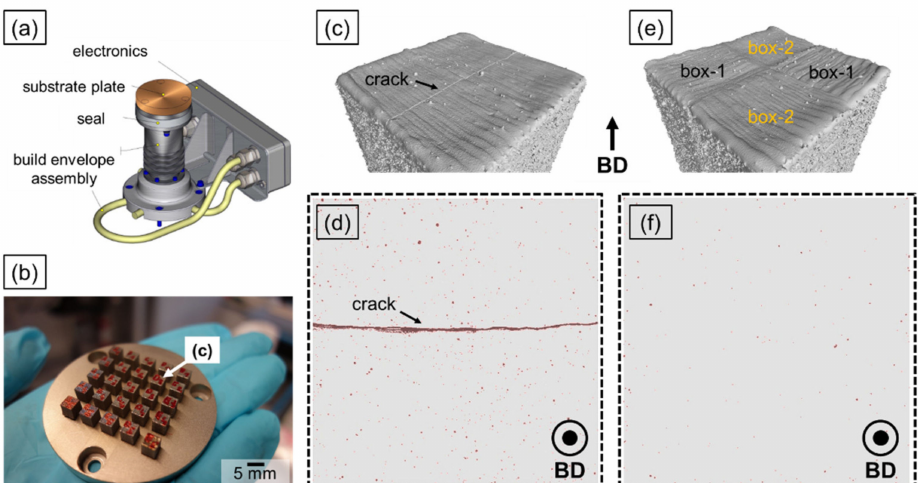
Figure 1. Overview of the machine setup used and selected Fe-Mn-Al-Ni samples fabricated at Leibniz IFW Dresden. An in-house developed build envelope (substrate plate diameter of 67 mm) was used for processing at a fixed temperature of 500 ◦ C ( a ). Process parameter optimization for Fe-Mn-Al-Ni ( b ) considering varying laser power (right to left: 125–225 W) and scanning speed (top to bottom: 610–890 mm/s). Reconstructed CT-images ( c – f ) revealing that crack free samples (5 mm × 5 mm × 7 mm) can be manufactured using the optimized parameters laser power = 200 W, scanning speed = 680 mm/s, hatching distance = 0.12 mm, in combination with ( e , f ) a chessboard-like scanning pattern (2.5 mm × 2.5 mm × 2 mm box size). Box-1 and box-2, as depicted in ( e ) were scanned perpendicular to each other and were constantly rotated layer-by-layer, by 90 ◦ . Numerous pores and a major crack in case of ( c , d ) conventional stripe scanning without island separation are shown in red. Please note that the images in ( d , f ) show the analyzed, transparent volume of the cubes (top view) shown in ( c , e ),